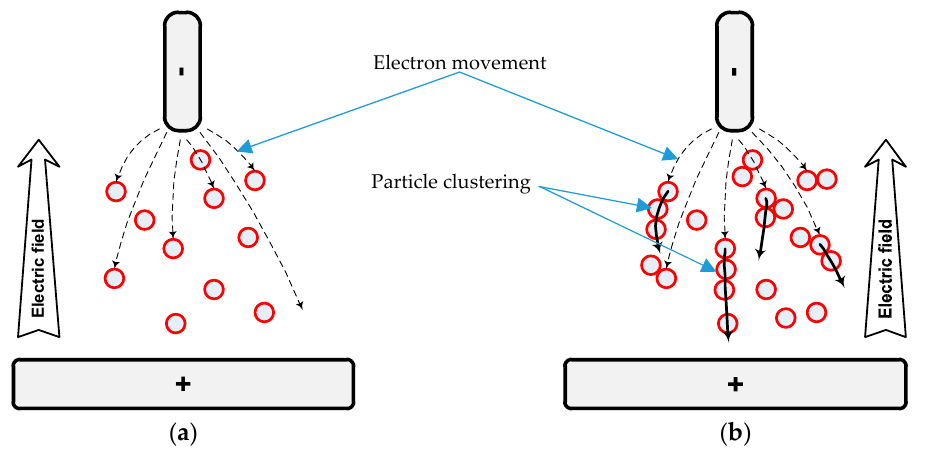
Figure 11. Schematic diagram of electron movement for nanofluids between two electrodes ( a ) at inception condition and ( b ) steady state condition.